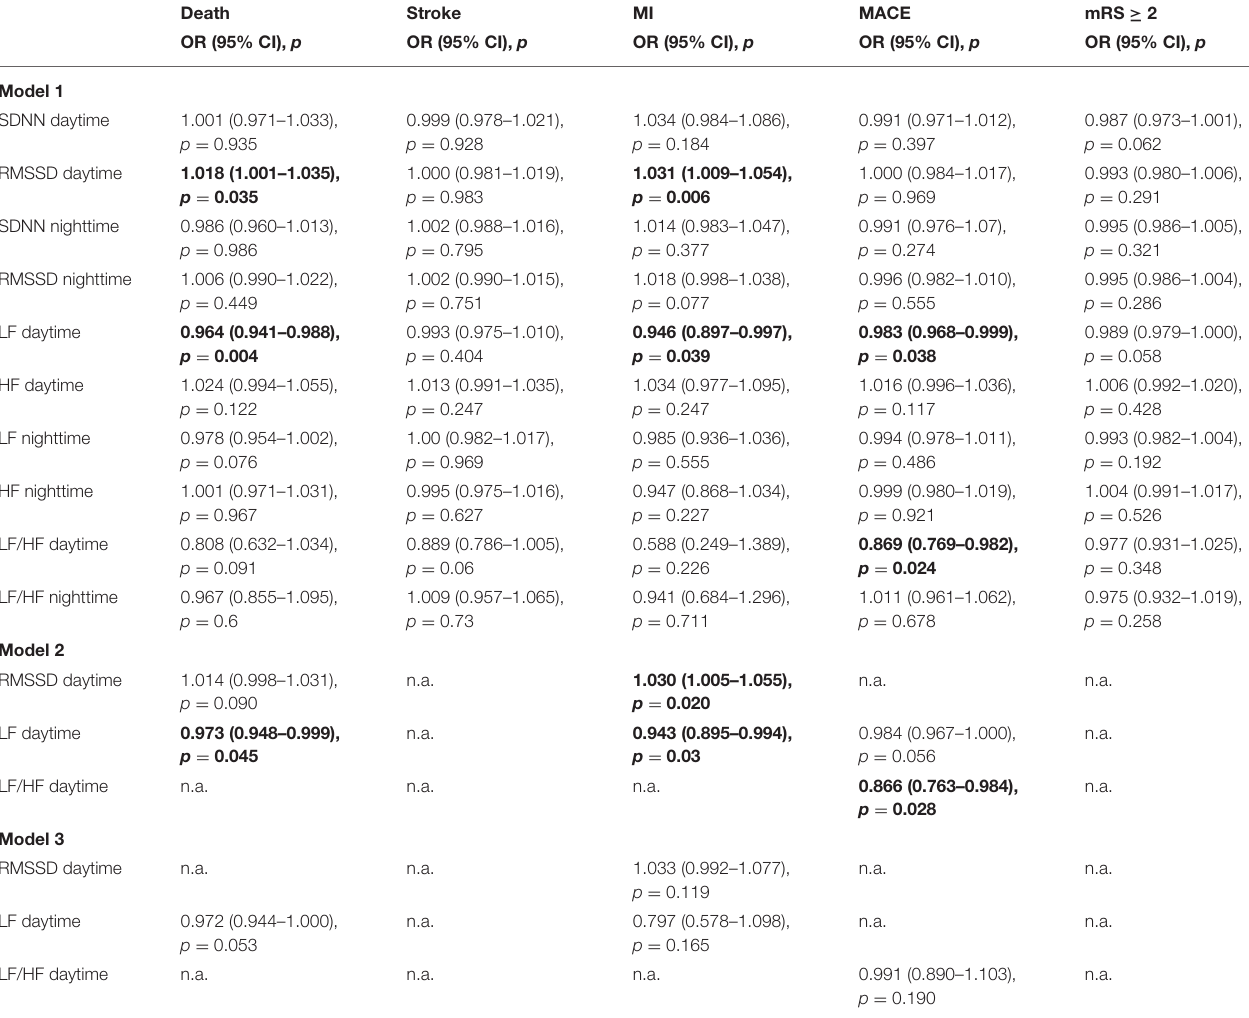
TABLE 3 | HRV and outcome at 365